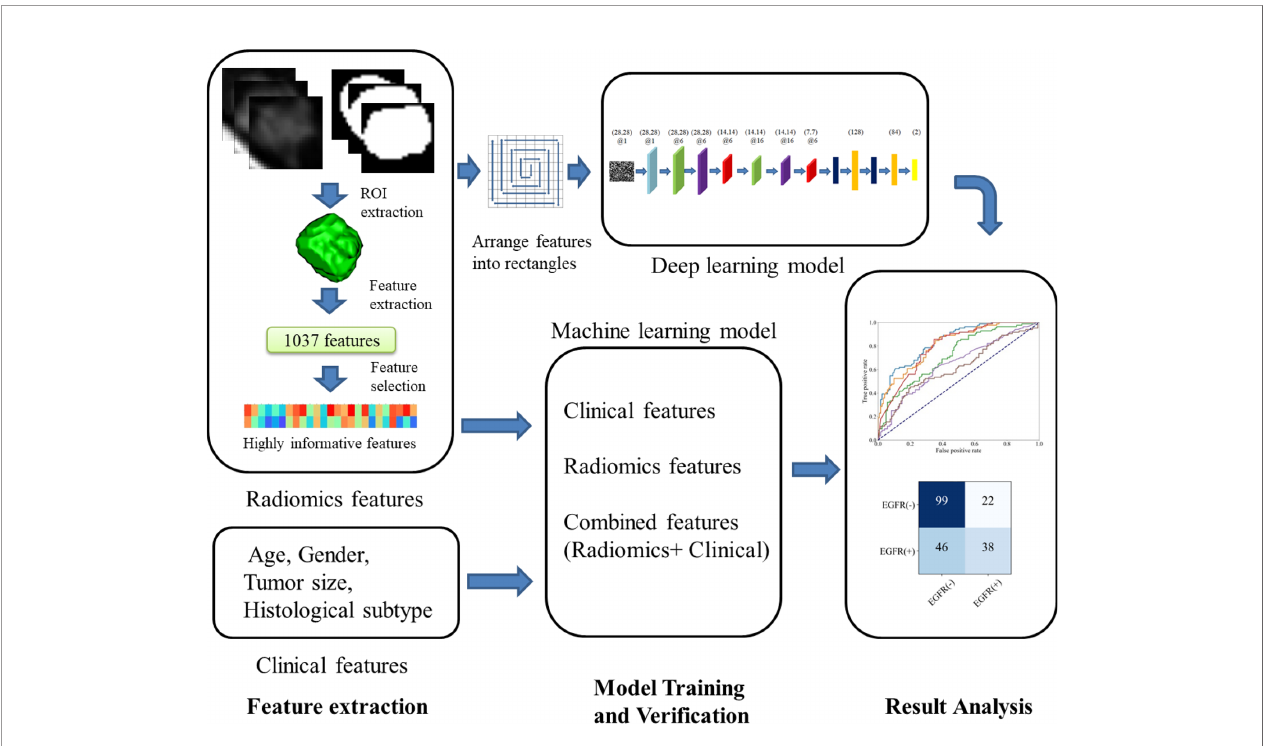
FIGURE 1 | Flow chart of our